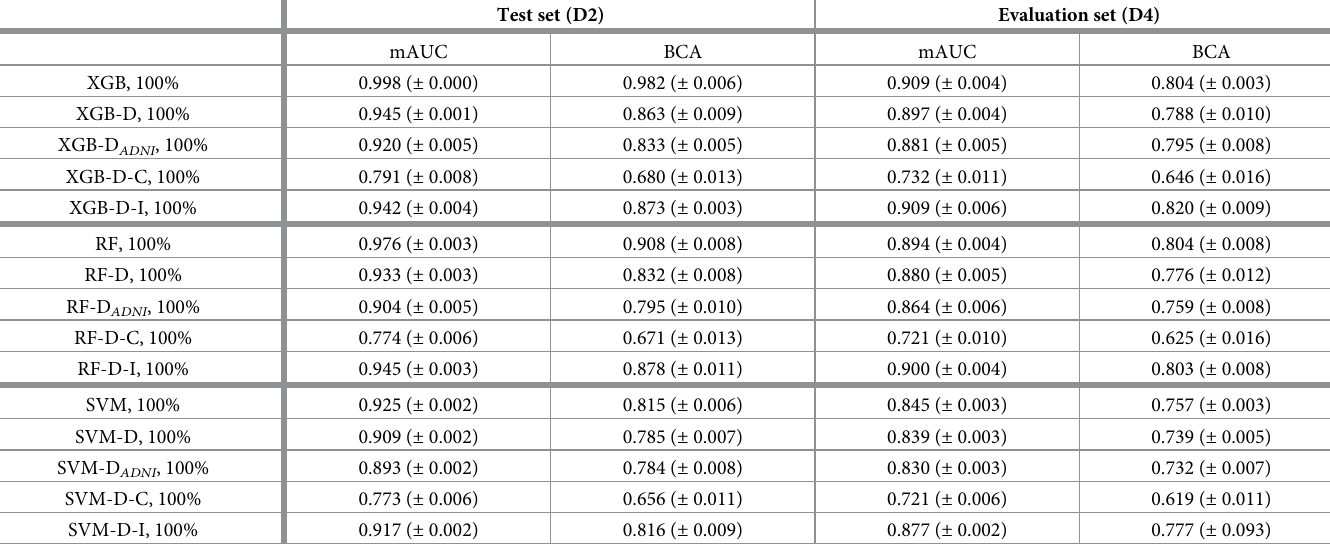
Table 3. Performance obtained with the methods considered in this work on the test (D2) and evaluation (D4)